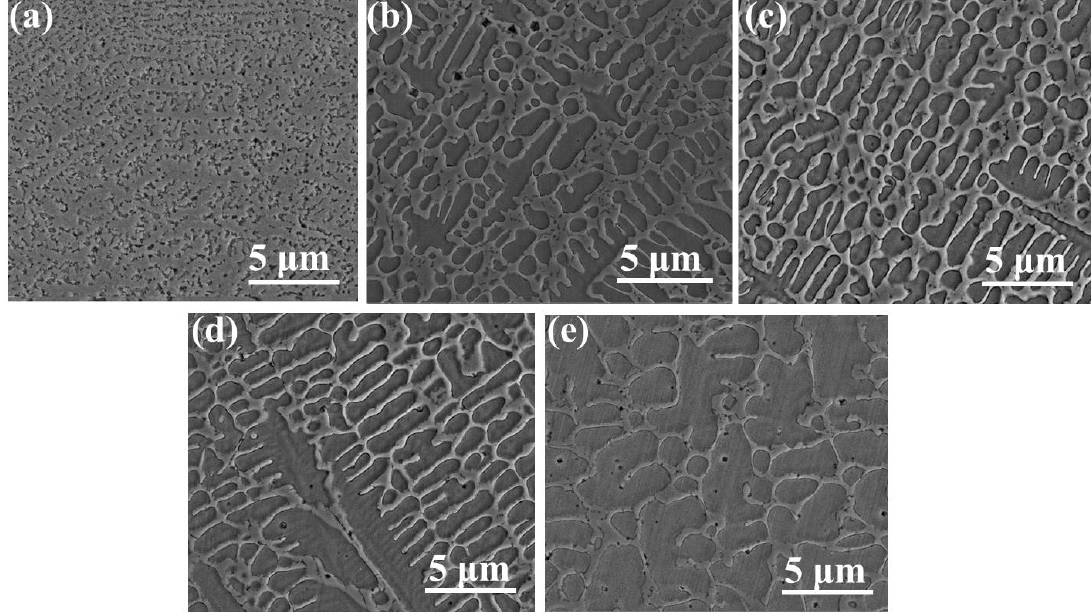
Figure 2. Scanning electron microscope (SEM) images of the microstructures of different printed samples, ( a ) Sample A, ( b ) Sample B, ( c ) Sample C, ( d ) Sample D, and ( e ) Sample E.